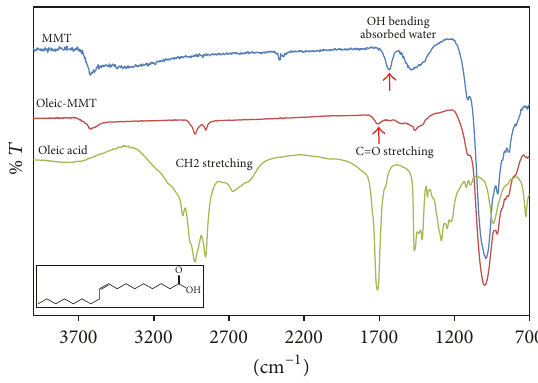
Figure 1: FTIR spectra of oleic acid, MMT, and modified clay